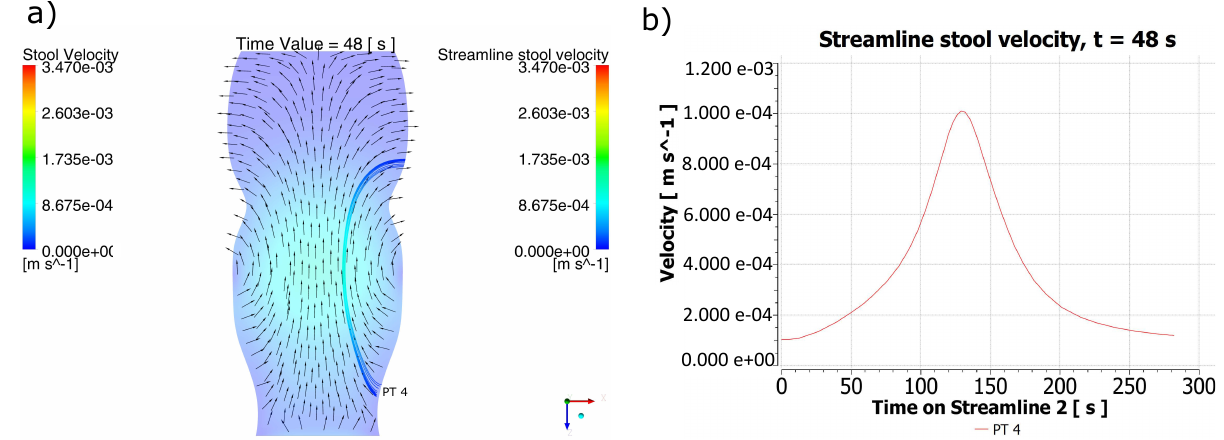
Figure 5. Behavior of the stool for t = 48 s. ( a ) Stool flow lines from the region of the PT 4 polyp for t = 48 s. ( b ) Velocity for the stool flow lines. It can be identified that in the PT4 particle release area, the direction of the fecal mass formed a retrograde trajectory. However, due to changes in the position of the peristaltic contraction, there was a variation in the magnitude of the maximum velocity reached during a new predicted trajectory, indicating a region much further from the point of origin of the biomarker particles, which allows us to state that the direction of the trajectory is retrograde for the type of contraction contemplated, but the site of impact with the predicted colonic wall varies depending on the position of the